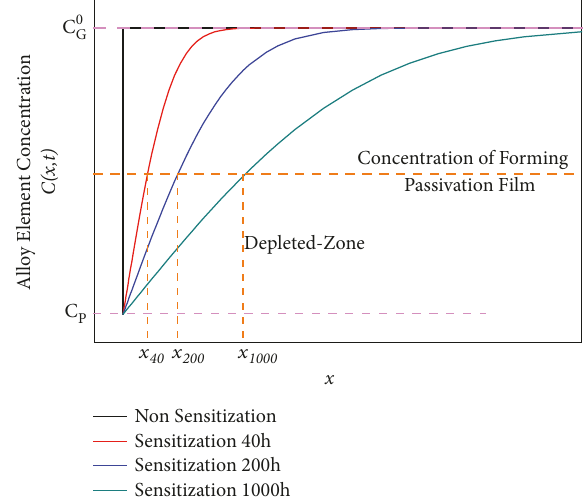
Figure 8: The relationship between aging time and the alloy composition and the width of the depleted